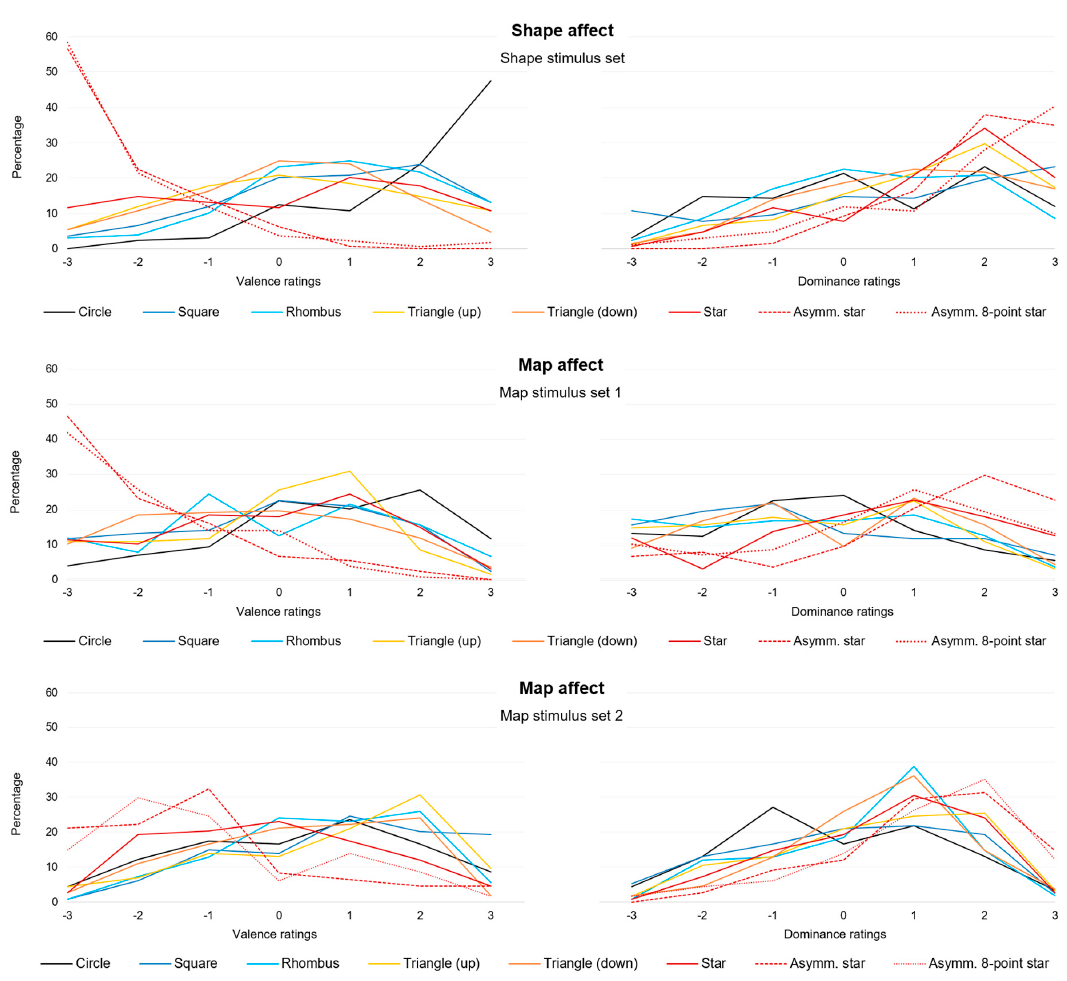
Figure 3. A ff ective quality ratings of valence (left) and dominance (right) of eight stimuli in three stimulus conditions.